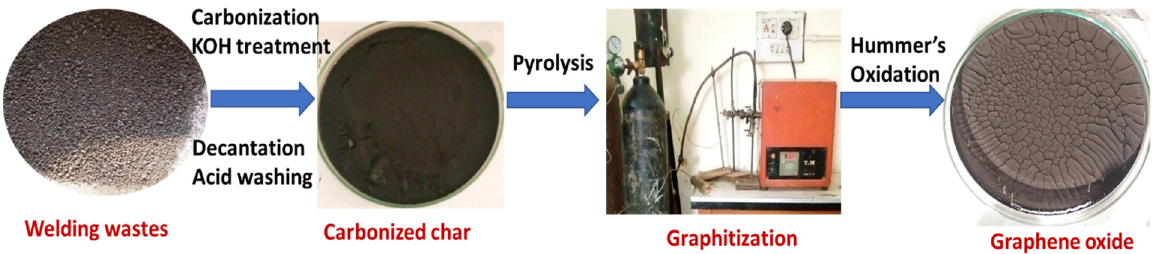
Figure 1. Stepwise synthesis of GO from welding wastes.